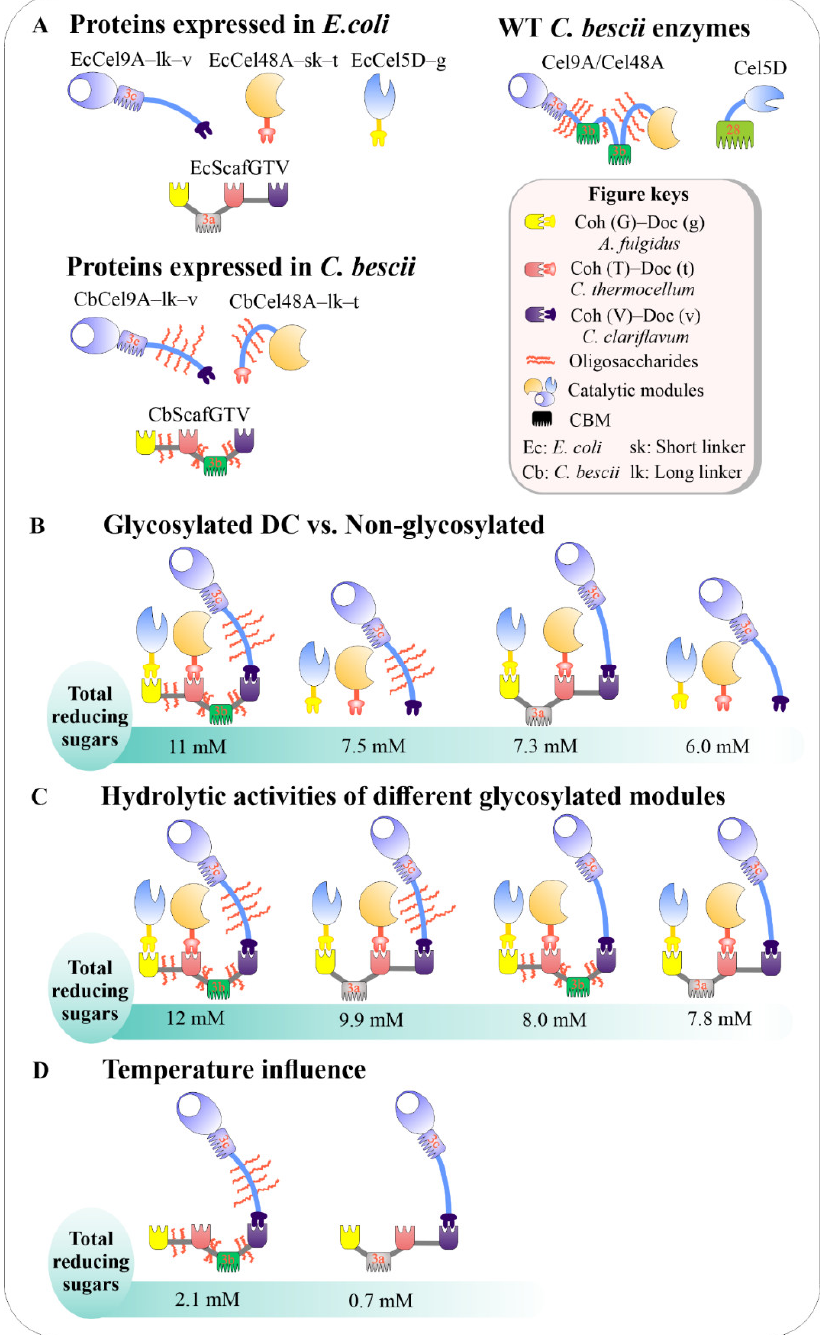
Figure 8. Development of C. bescii -based DC. ( A ) Conversion of the WT C. bescii enzymes into chimeric forms using E. coli or C. bescii as an expression host. ( B ) Influence of linker length in DC enzyme components on hydrolytic efficiency (24-h incubation at 75 ◦ C, 4% ( w / v ) Avicel). ( C ) Com- parison of hydrolytic activities between C. bescii -based DC, chimeric C. bescii enzymes, WT C. bescii enzymes, and native C. thermocellum cellulosome, (72-h incubation at 75 ◦ C, 4% ( w / v ) Avicel). ( D ) Ef- fects of temperature on the activities of C. thermocellum -based DC and C. bescii -based DC (Heat treatment at 85 ◦ C for 3 h, followed by 16-h incubation at 75 ◦ C, 4% ( w / v )